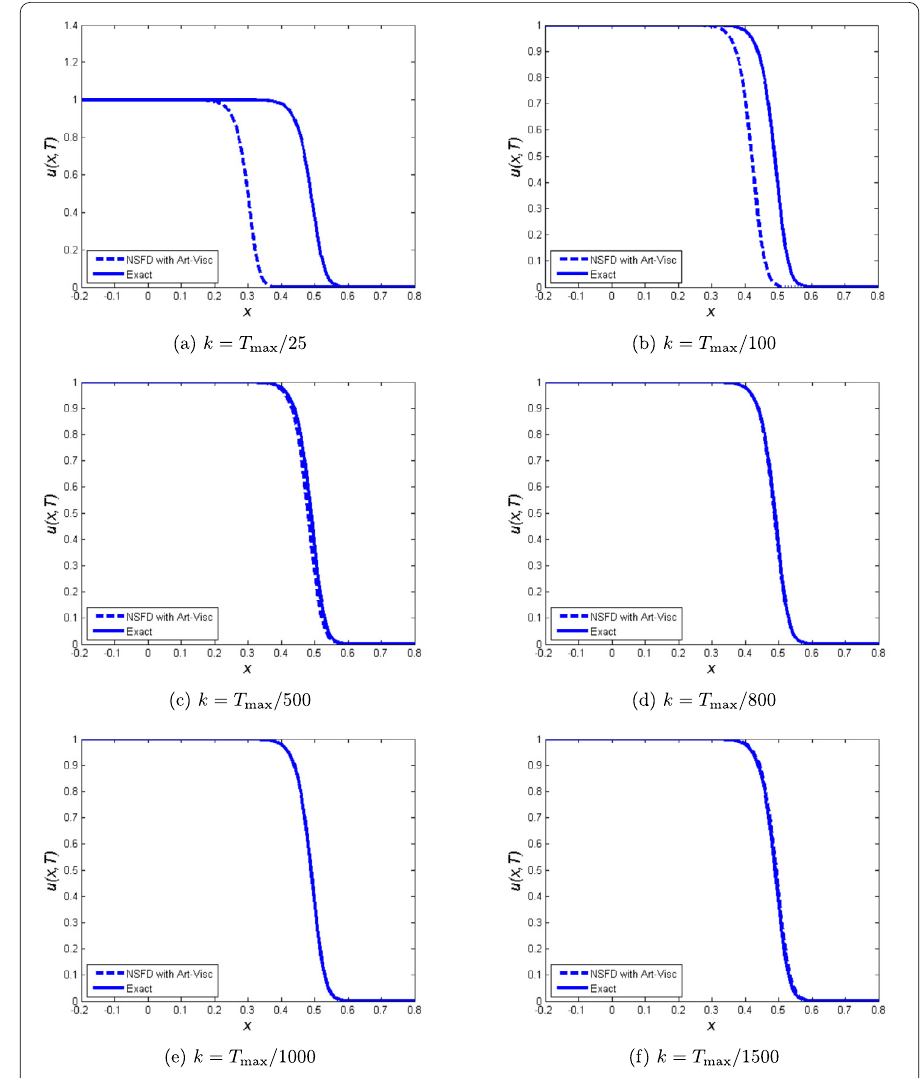
Figure 6 Plot of u against x for Problem 1 using NSFD with artificial viscosity at time 2.5 × 10 –3 , at some different values of k and h = 0.01, σ = 2.0, T max = 2.5 × 10